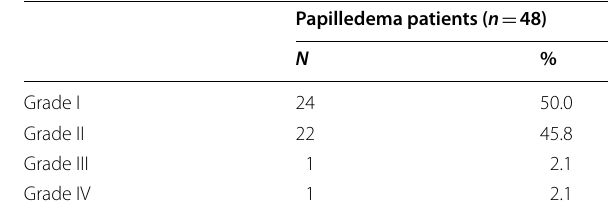
Table 2 Demographic distribution of the studied patients group